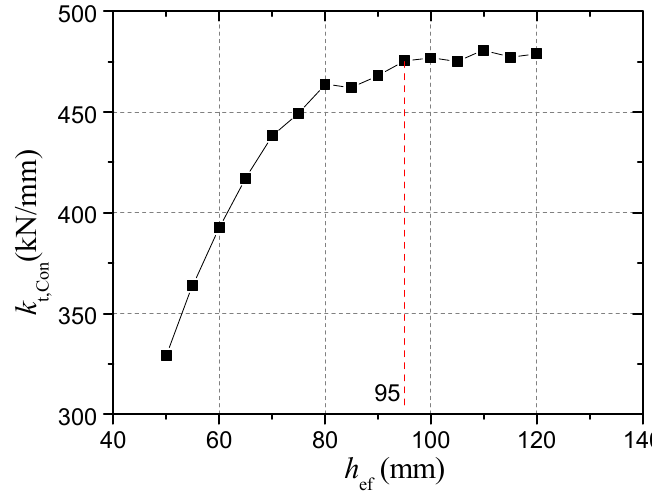
Figure 20. Effect of the effective embedment depth on the stiffness.